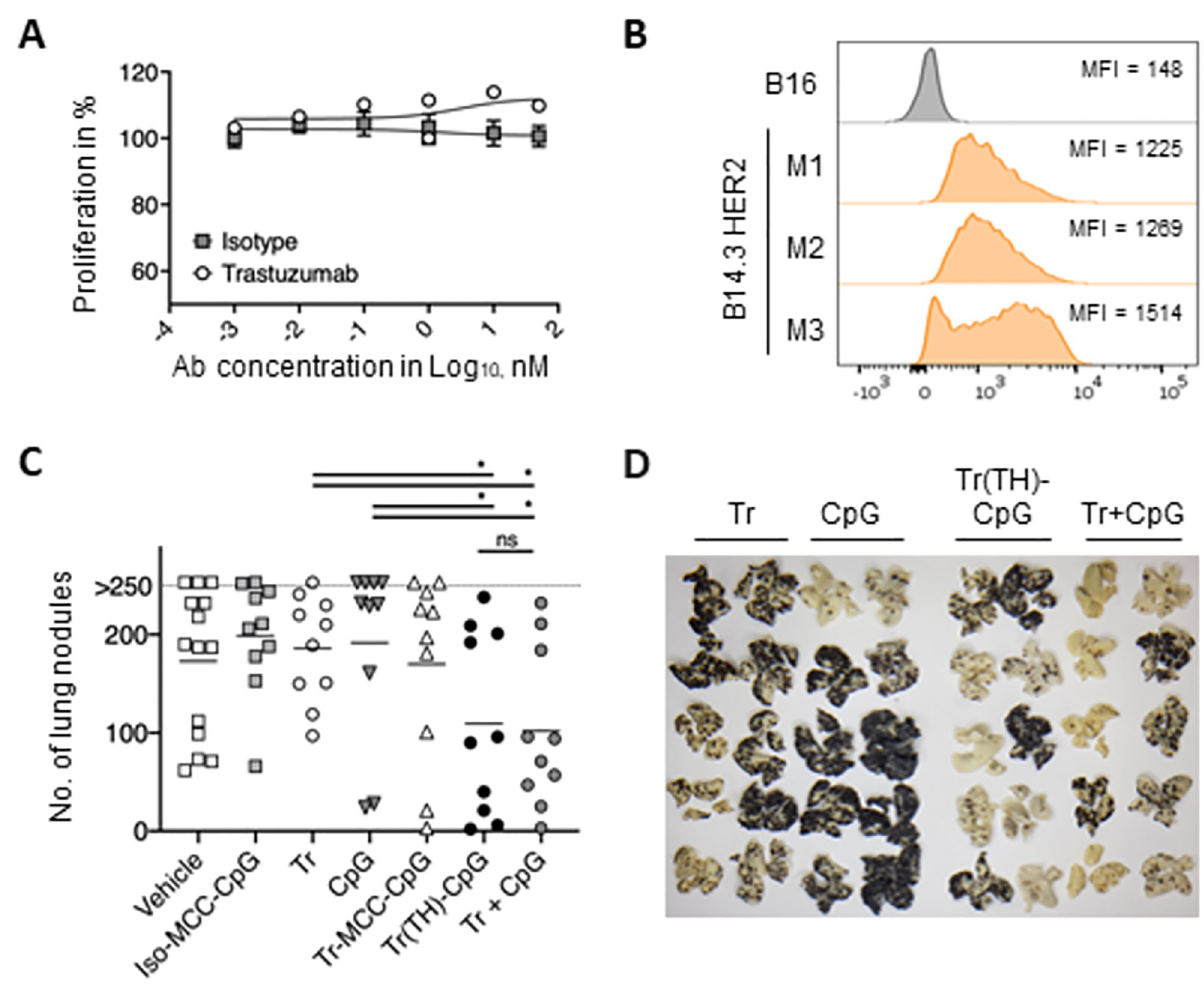
Fig 6. Anti-tumor response upon repeated treatment with TH-Trastuzumab-MCC-CpG in the B14.3 HER2 pseudo-metastasis mouse model. (A) B14.3 HER2 cells were cultured in the presence of Trastuzumab for 48h and tumor cell proliferation was measured in the MTS assay. (B) Expression of human HER2 was determined by flow cytometry on B14.3 HER2 cells retrieved from 3 representative mouse lungs 15 days after tumor inoculation. B16 tumor cells served as HER2-negative control. The MFI of each samples is depicted. (C) Mice (n = 10 for all groups, except vehicle n = 9) were inoculated with B14.3 HER2 cells on day 0 and treated at days 4, 8 and 11 with 2mg/kg body weight of antibody or antibody conjugate. Mice were treated with Trastuzumab (Tr) and CpG ODN (CpG) alone or in combination. The dose of CpG provided in free form was equivalent to the dose of conjugated CpG. Trastuzumab-MCC-CpG (Tr-MCC-CpG) and TH-Trastuzumab-MCC-CpG (Tr(TH)-CpG conjugates were compared and isotype control antibody-MCC-CpG (iso-MCC-CpG) conjugates were used as control. The number of pulmonary nodules on the lung surface was determined at day 18 post-tumor inoculation. Results for individual mice and mean number of lung tumor nodules per group are shown. Mann-Whitney T test; � p < 0.05; ns—not significant. (D) Representative images of mouse lungs bearing B14.3 HER2 tumors at day 18 post tumor inoculation are shown.